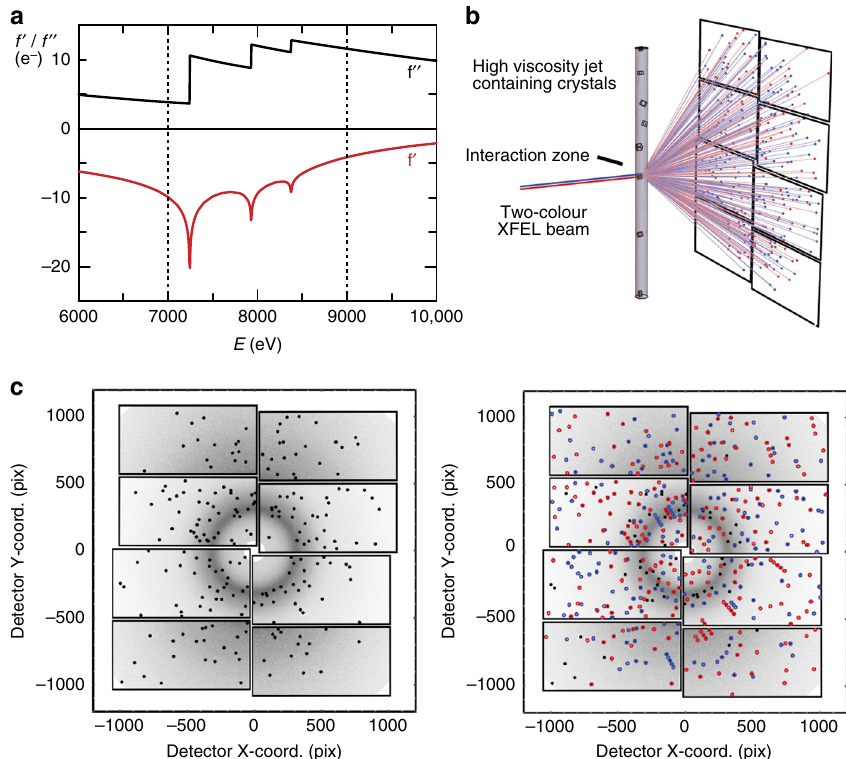
Fig. 1 Two-colour serial femtosecond crystallography experiment. a The two photon energies were chosen to be below (7 keV) and above (9 keV) the L- edges of gadolinium. This results in a strong anomalous difference and a large spatial separation of re fl ections. b Experimental setup. c Two-colour diffraction pattern before ( left ) and after ( right ) indexing in the 9 keV colour ( blue ) and 7 keV colour ( red ). The diffuse ring is caused by the grease carrier medium used to deliver the lysozyme crystals into the XFEL